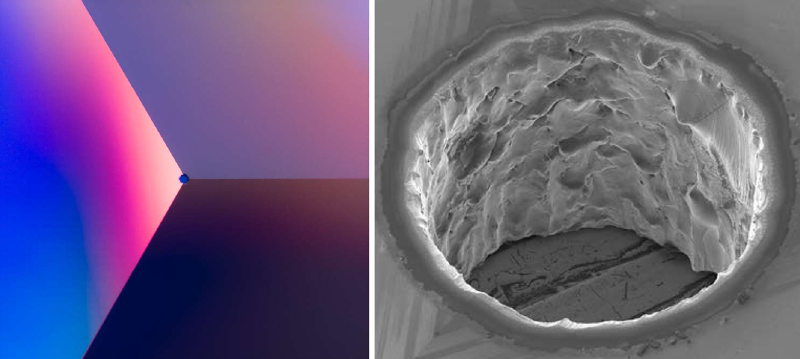
FIG. 6. Left: The grating chip with hole in the center. Right: SEM image (close-up) of the hole in the center.